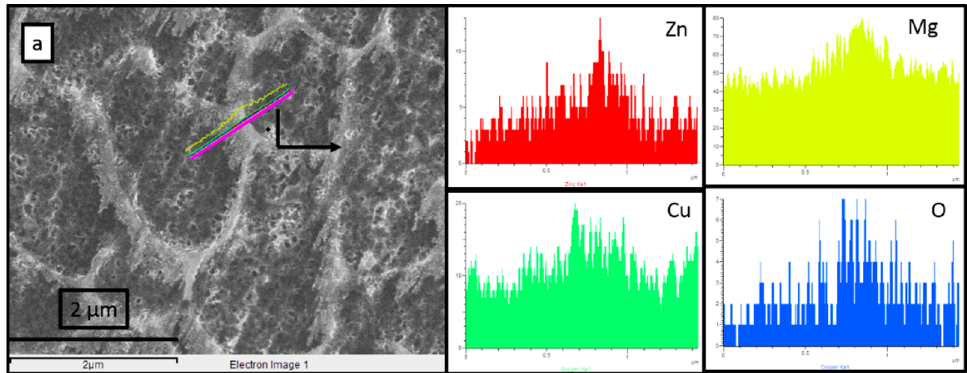
Figure 4. Microstructural morphology and EDS line scan results on the studied particles. Concen- tration profiles of solute elements show the compositional variation across the boundaries. The coloured lines mark measurement locations.